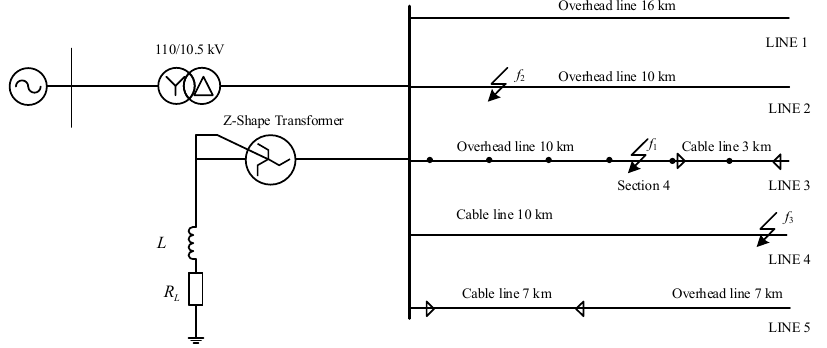
Figure 7. Schematic diagram of single-phase grounding fault simulation of resonant grounding sys- tem.